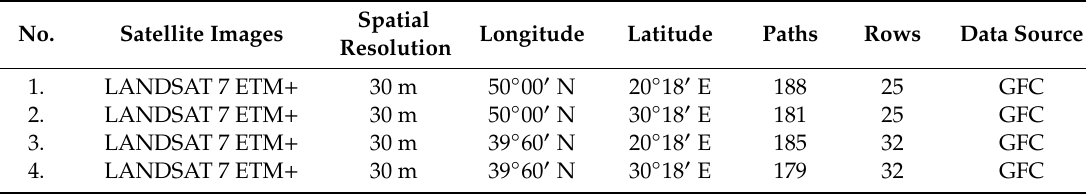
GFC: Global Forest